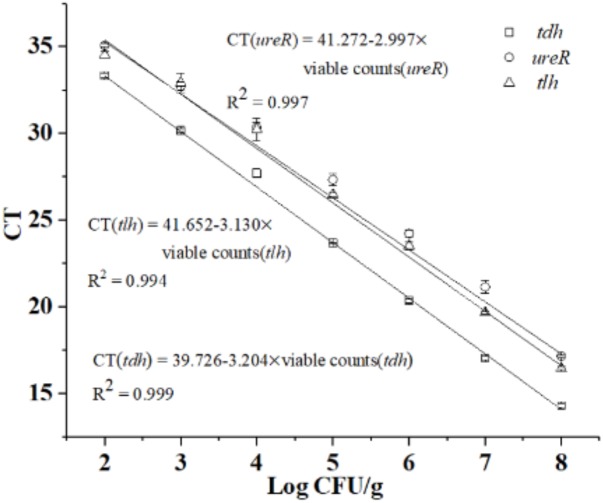
Standard curves of tlh, tdh, and ureR in novel qPCR.